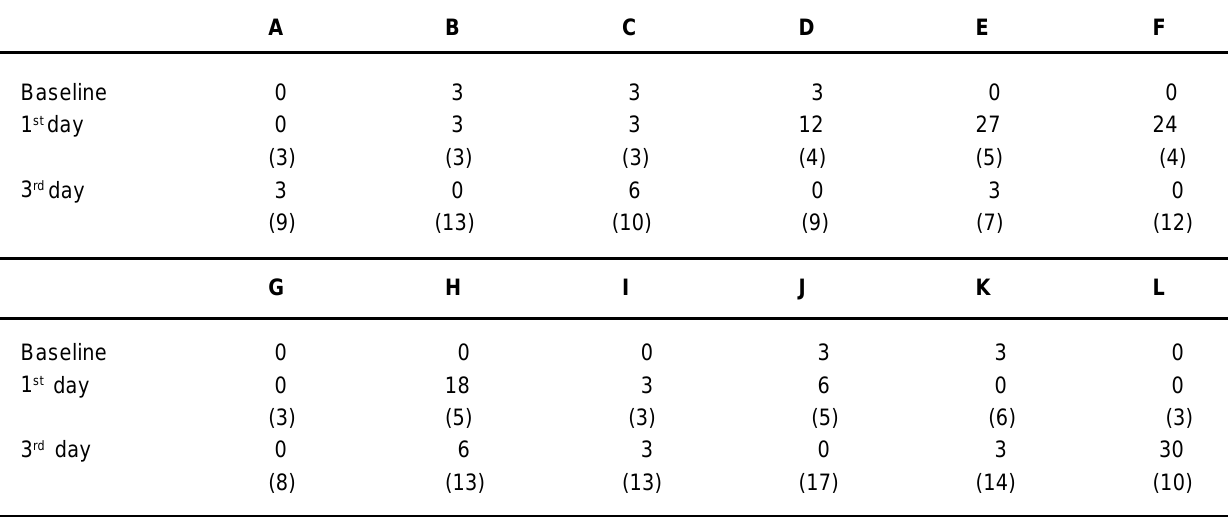
TABLE 1- Microbial counts at 0, 1-day and 3-day clinical use of the gutta-percha packages distributed to 12 students coded from A to L. The values in parentheses indicate the number of root canals filled at the end of the day. The values in parentheses for the third day row indicate the sum of root canals filled from day 1 to day A B C